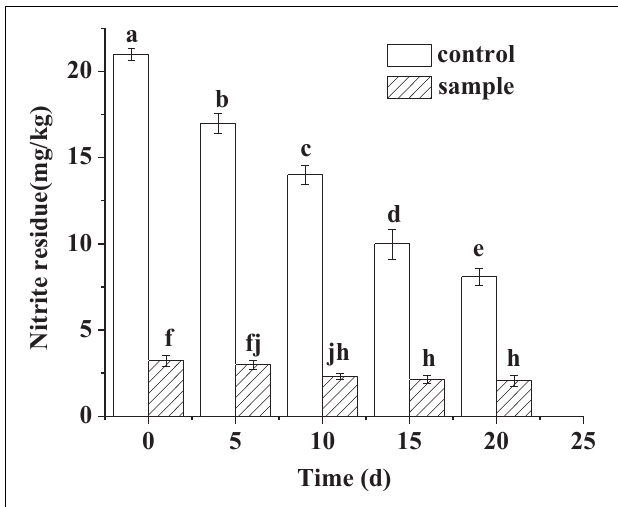
FIGURE 3 | The TBARS content of the sausages during ripening period, in which different lowercase letters meant that TBARS content was significantly different ( p < 0.05).